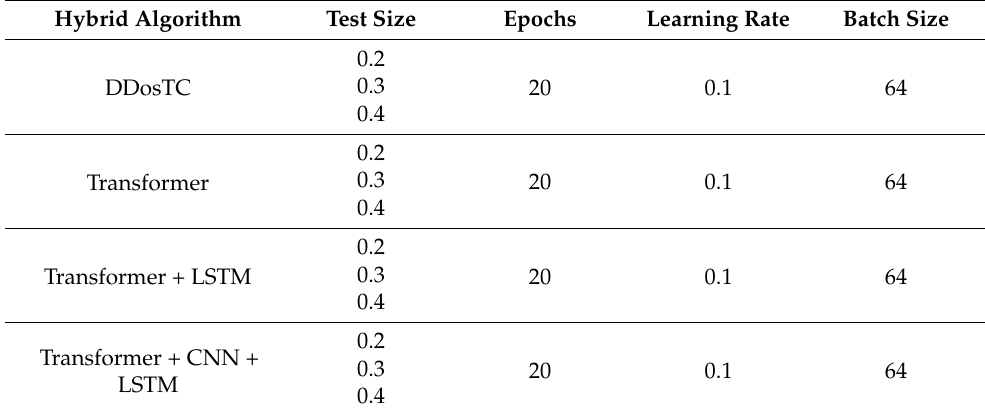
Table 1. Detailed technical description of hybrid algorithms based on transformers.